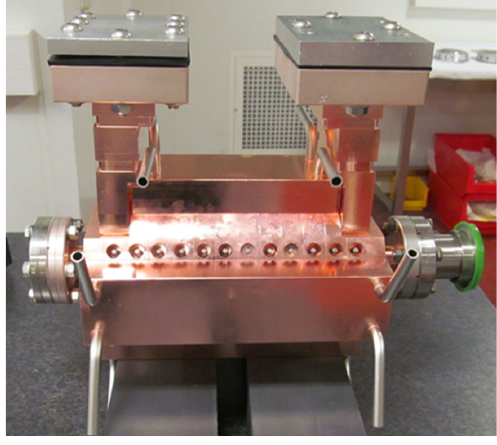
FIG. 5. Picture of the BTW prototype.